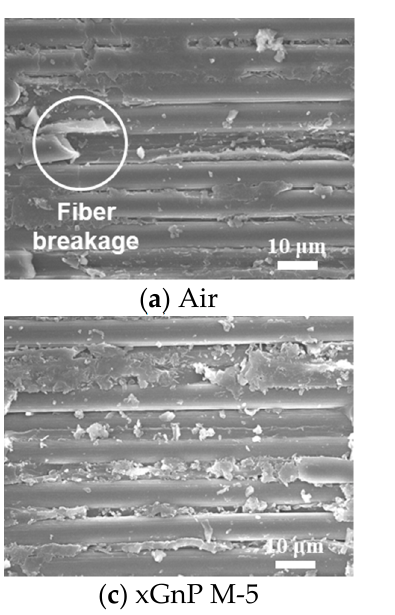
Figure 15. FE-SEM images of carbon fiber cutting angle of 90° (× 1400).